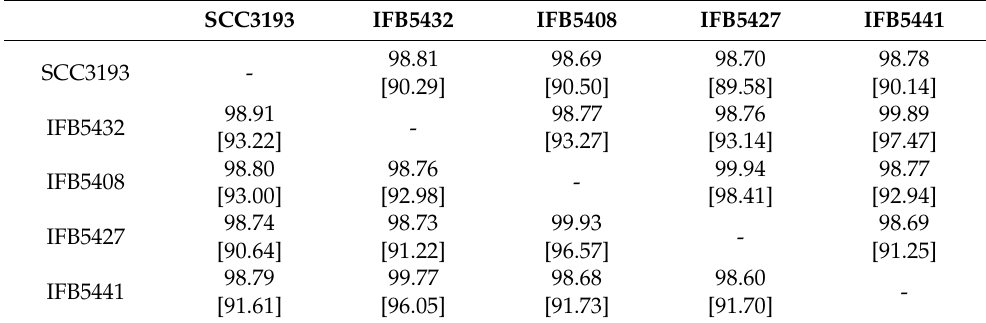
Table 2. ANIb-based pairwise genome comparisons between the studied P. parmentieri